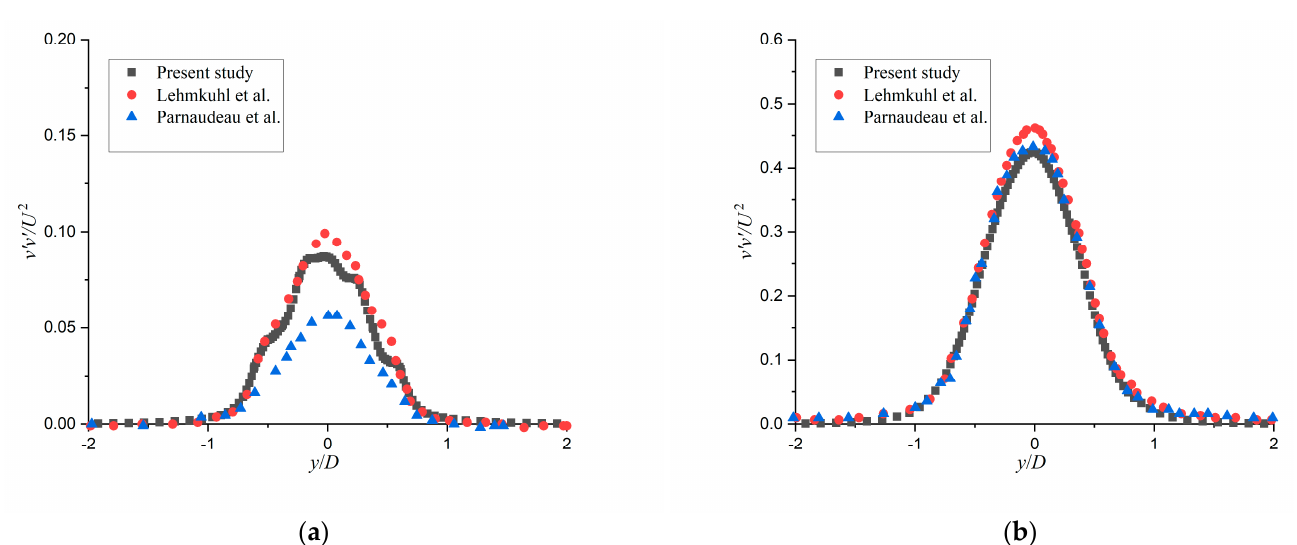
Figure 4. The second-order statistics for the streamwise velocity profile at different locations: ( a ) x/D = 1.06; ( b ) x/D = 2.02 [29,30].